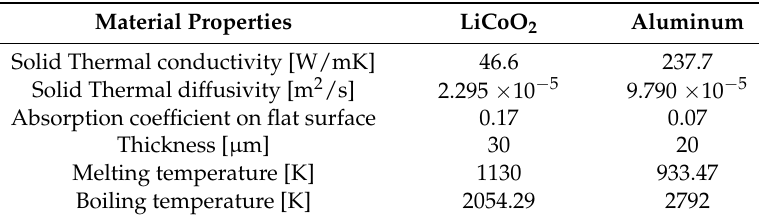
Table 2. Material properties of cathode